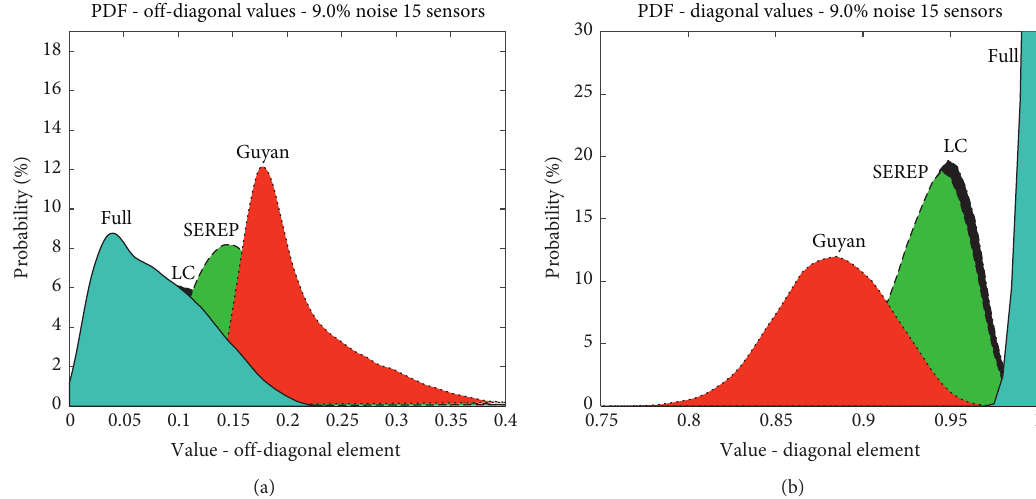
Figure 10: (a) PDFs of the maximal off-diagonal elements. (b) PDFs of the minimal diagonal elements. Both with 9 pct. Noise on the modes and 15 sensors.